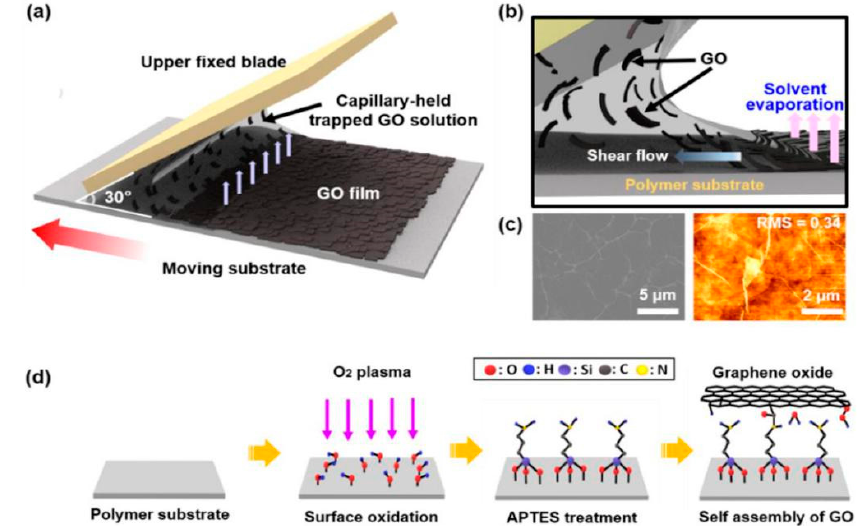
Figure 10. Steps of fabrication of the laser-ablated reduced-graphene oxide-based thin film via flow-enabled self-assembly. Reproduced from Park, R., Kim, H., Lone, S., Jeon, S., Kwon, Y., Shin, B. and Hong, S., 2018. One-Step Laser Patterned Highly Uniform Reduced Graphene Oxide Thin Films for Circuit-Enabled Tattoo and Flexible Humidity Sensor Application. Sensors, 18(6), p.1857 [98] .